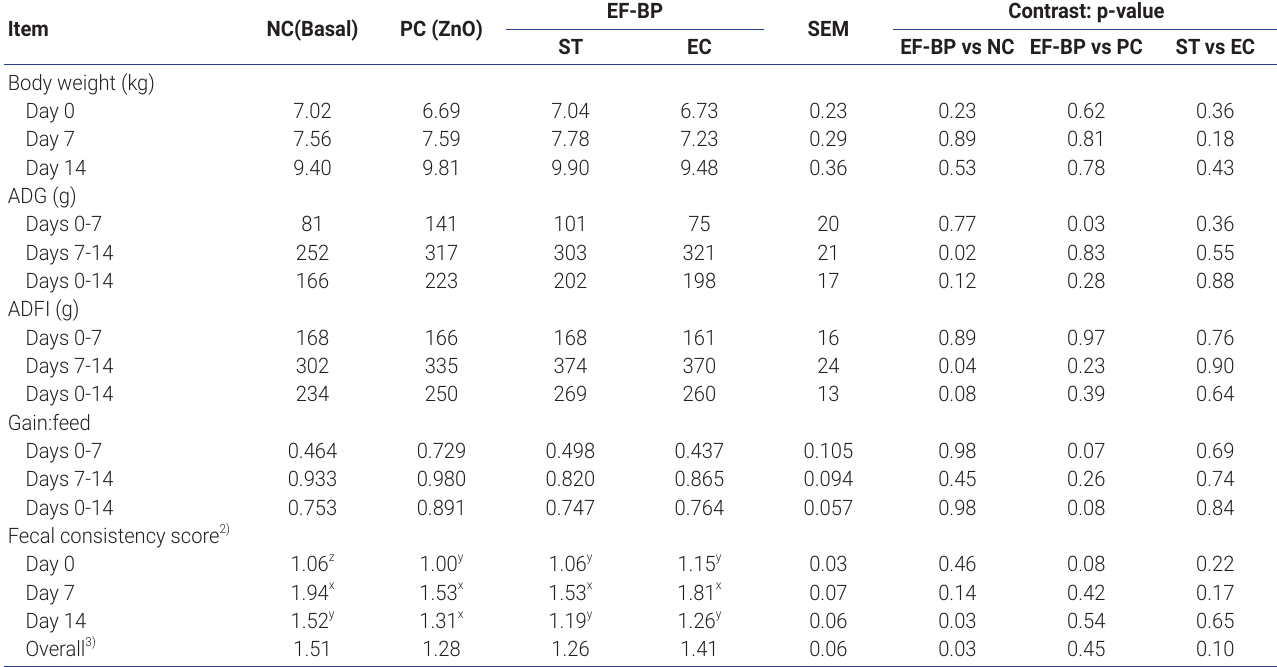
Table 5. Effects of probiotic Enterococcus faecium plus bacteriophages on growth performance and fecal consistency of group-fed weanling pigs (Experiment 2)